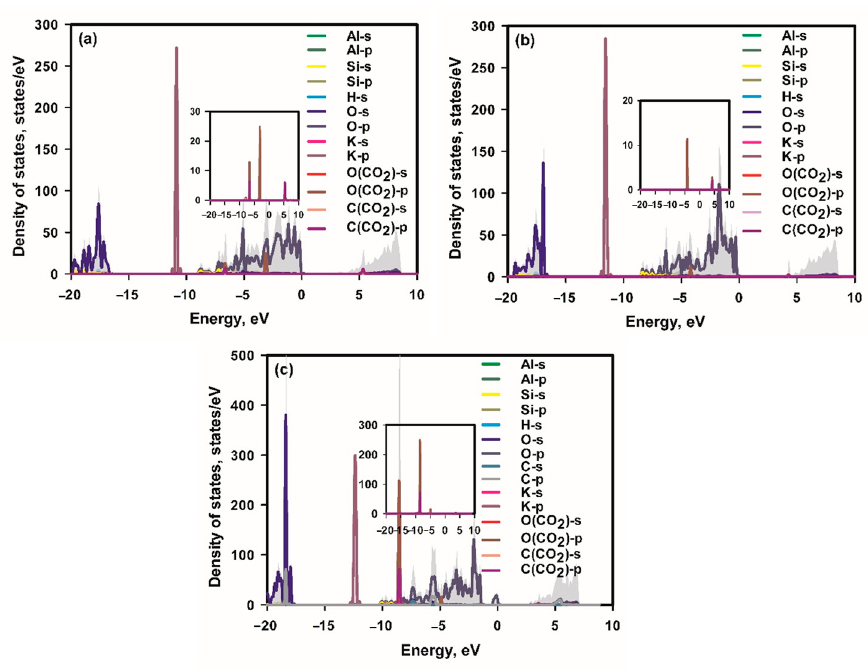
Figure 8. Projected density of states of adsorbed CO 2 on bulk mica ( a ), a mica monolayer ( b ) and K 2 CO 3 deposited mica monolayer ( c ). The inset is a magnification of states of C and O of CO 2 . Similarly, the main K state located at − 11.6 eV shows no overlapping with any states of CO 2 . With regard to a K 2 CO 3 deposited mica monolayer, the adsorbed CO 2 shows hybridization of O-2p and C-2p orbitals at − 8.4 eV. The overlapping of the O-2p state of a CO 2 molecule with O-2p states of the surface at − 4.9eV occurs, indicating the existence of electron transfer to CO 2 from the surface. However, the overlapping of the K state at − 12.4 eV with any states of CO 2 does not occur; therefore, no bonding is formed between CO 2